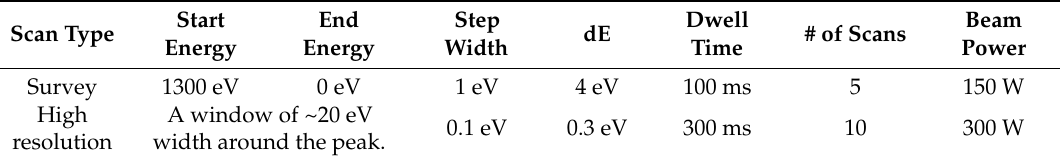
Table 2. Acquisition parameters for survey and high-resolution X-ray photoelectron spectrometer (XPS) spectra.